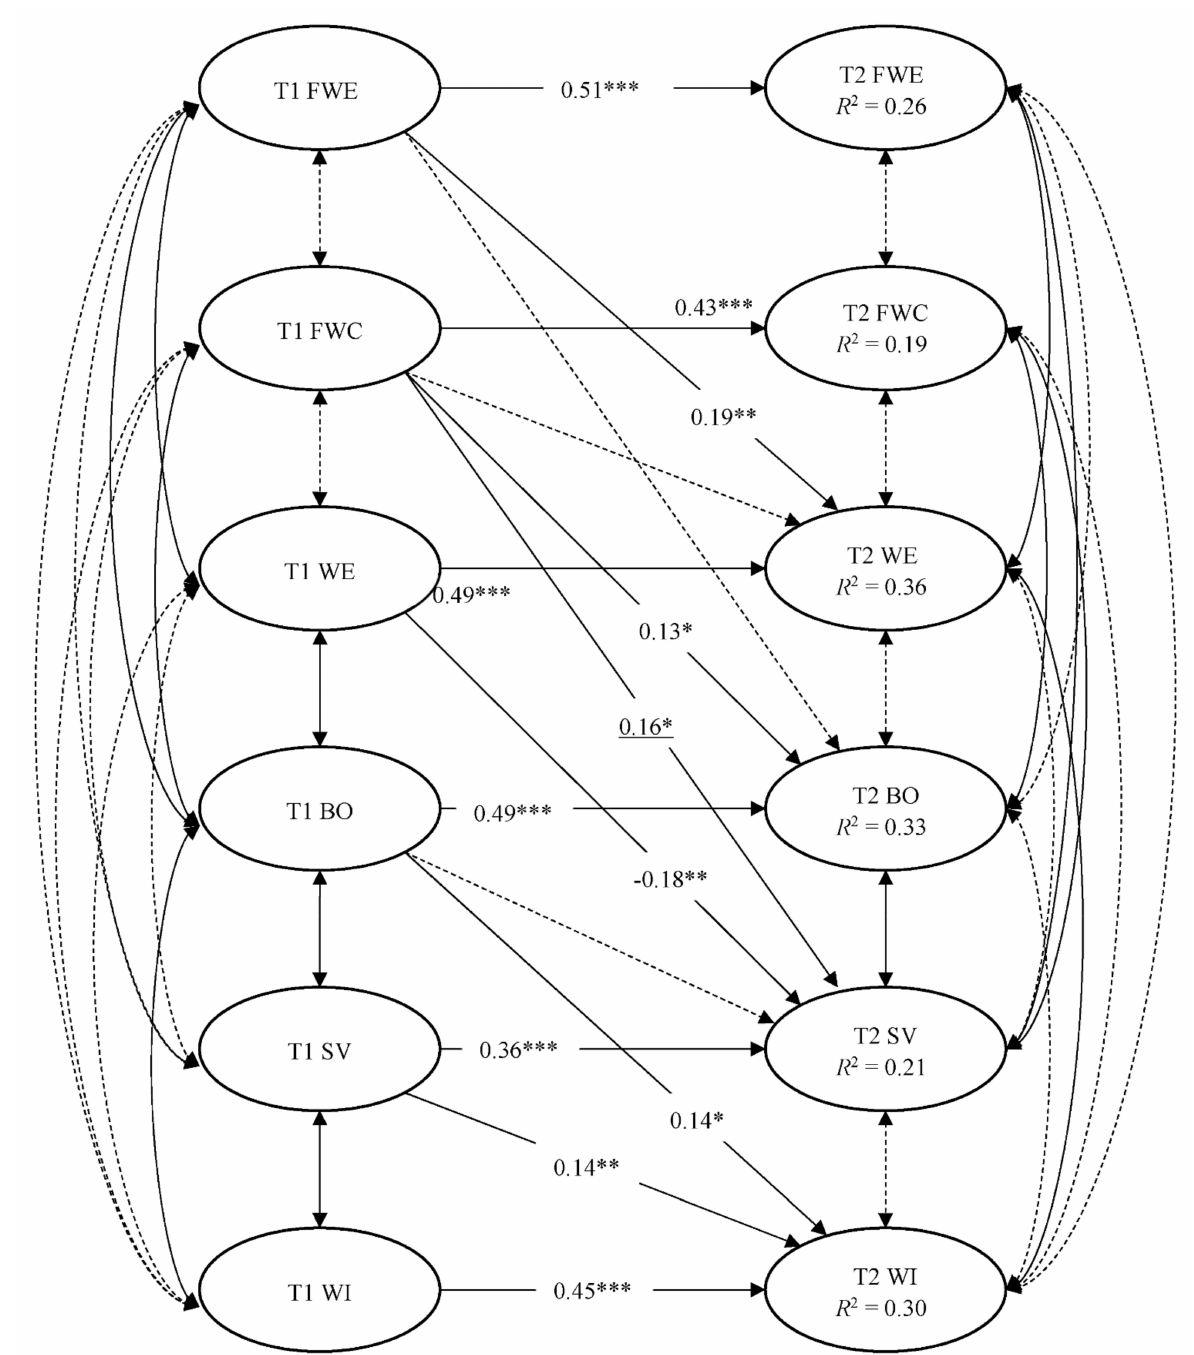
Figure 4. The final model. χ 2 (601, N = 233) = 849.42, p < 0.001, RMSEA = 0.042, 90% CI (0.035, 0.049), SRMR = 0.055, CFI = 0.97, TLI = 0.96, AIC = 13,029.93. FWE = family-to-work enrichment; FWC = family-to-work conflict; WE = work engagement; BO = burnout; SV = safety violations; WI = workplace injuries. Solid lines represent significant paths and covariances. Dashed lines represent non-significant paths and covariances. Standardized coefficients for significant paths are reported. Observed indicators and autocovariances between measurement errors are omitted for clarity. * p < 0.05. ** p < 0.01. *** p <